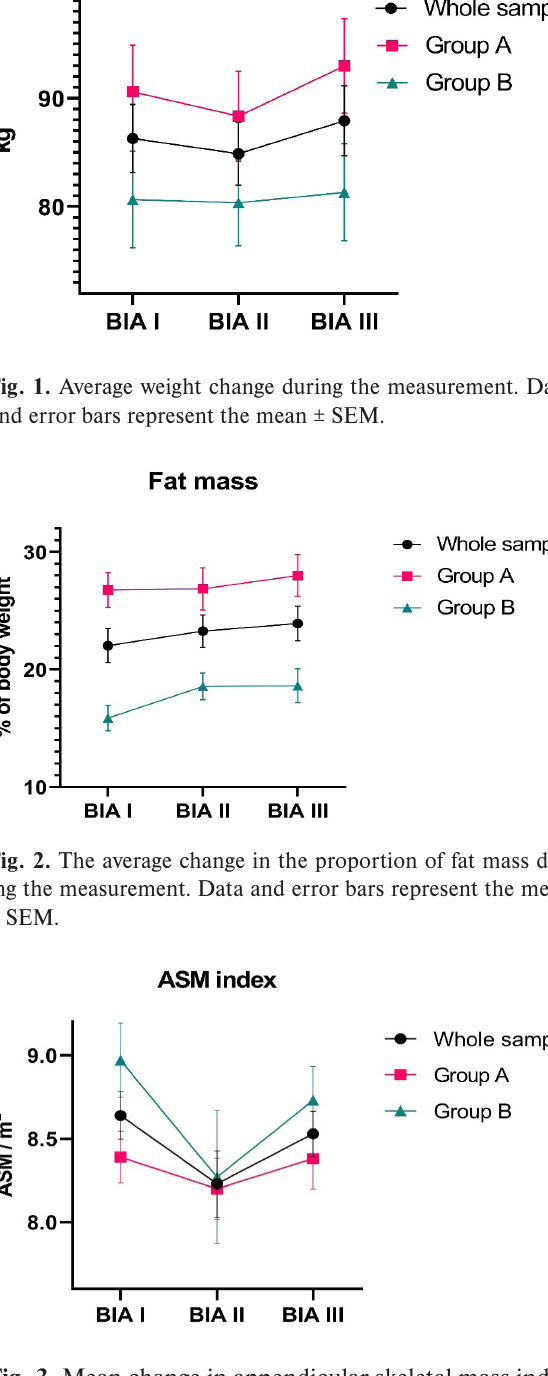
Fig. 3. Mean change in appendicular skeletal mass index (ASM/m 2 ) during BIA measurements. Data and error bars represent the mean ±